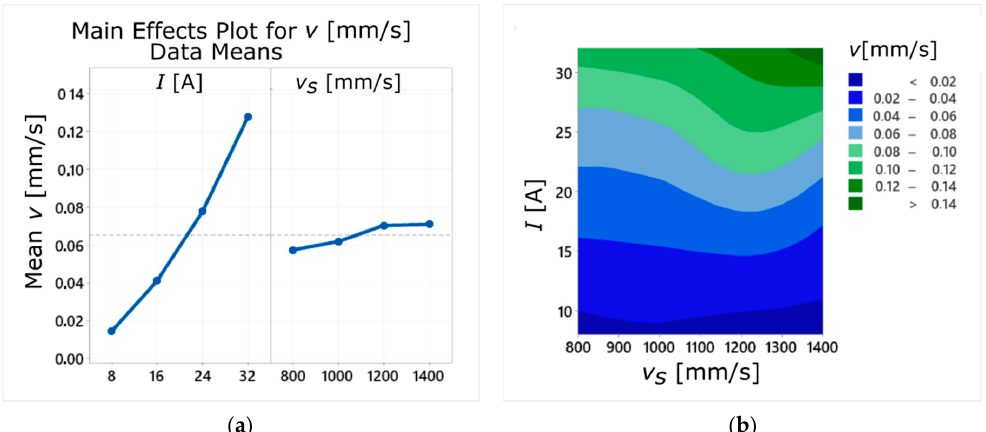
Figure 3. Influence of the process parameters ( I and v s ) on the values of the cutting speed v : ( a ) the main effects’ plot; ( b ) the contour plot.